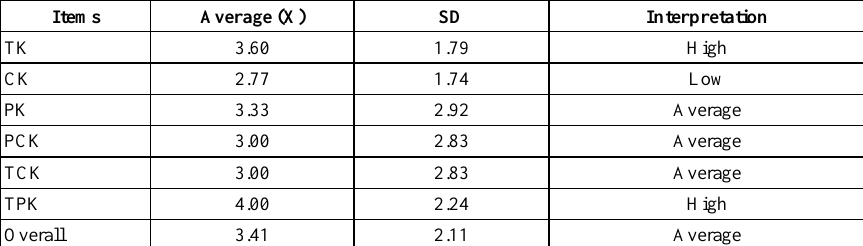
Table 5. Statistical description of TPACK area knowledge